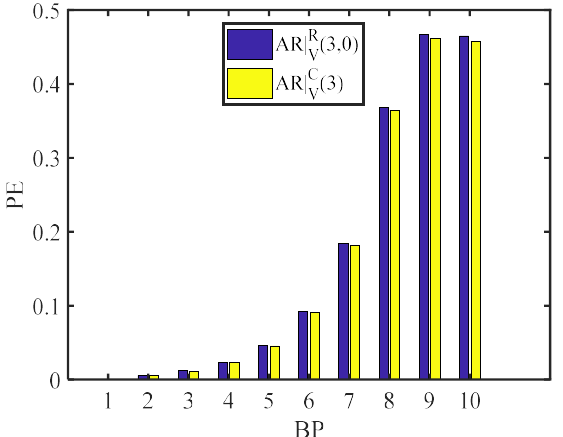
Figure 17. Bit position error of computing sigmoid